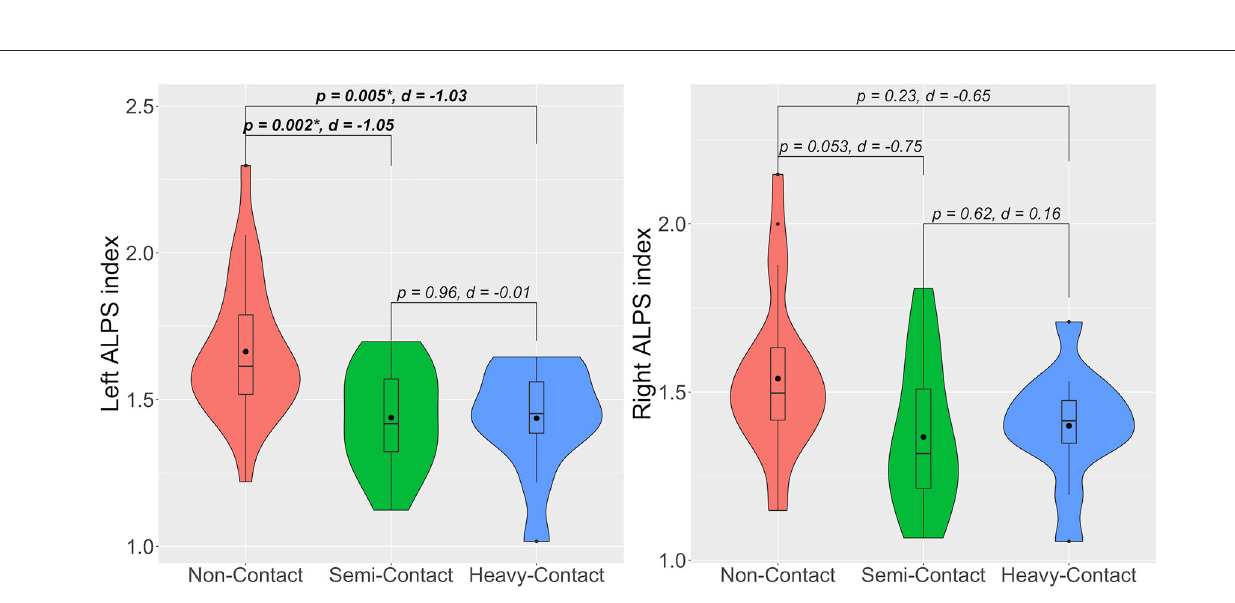
FIGURE2 Violin plots of left and right ALPS indices for noncontact (red), semicontact (green), and heavy-contact (blue) groups. Boxes indicate the interquartile range (75th [upper horizontal line] and 25th [lower horizontal line]), mean (bold black line), and median (black dot). Upper whiskers indicate the maximum value of the variable at a distance of 1.5 times the quartile range from the 75th percentile value. Lower whiskers indicate the distance to the 25th percentile value. Small dots indicate an outlier. Surrounding the boxes (shaded area) on each side is a rotated kernel density plot. The figure shows p -values after adjusting for age, years of education, HbA1c, and Cohen’s d . *Significant to P < 0.05. ALPS, analysis along the perivascular